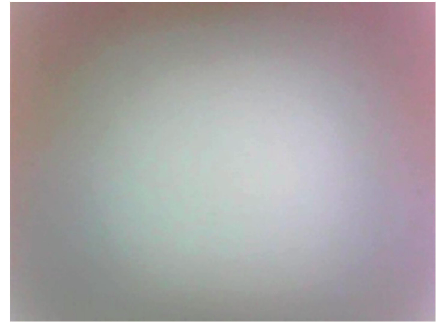
Figure 6. A background image.